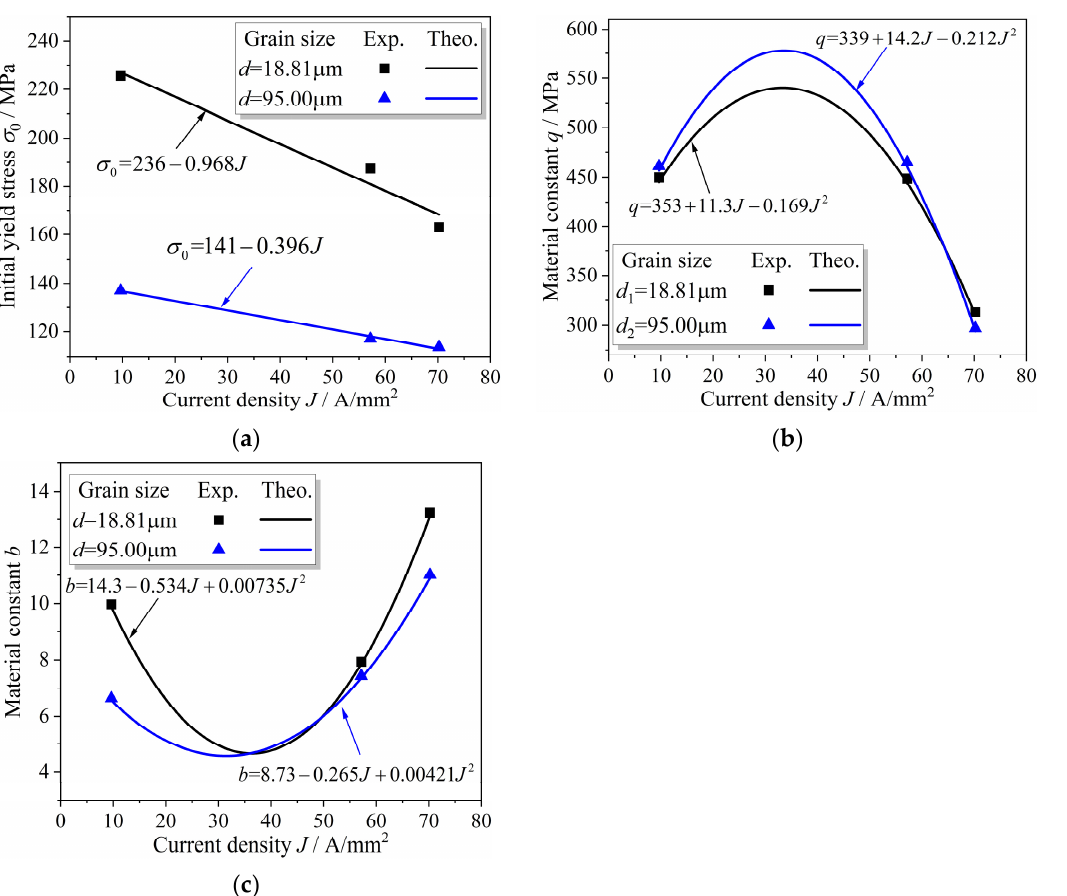
Figure 7. Relation between material parameters and current density: ( a ) The initial yield stress σ 0 ; ( b ) Material constant q ; ( c ) Material constant b .